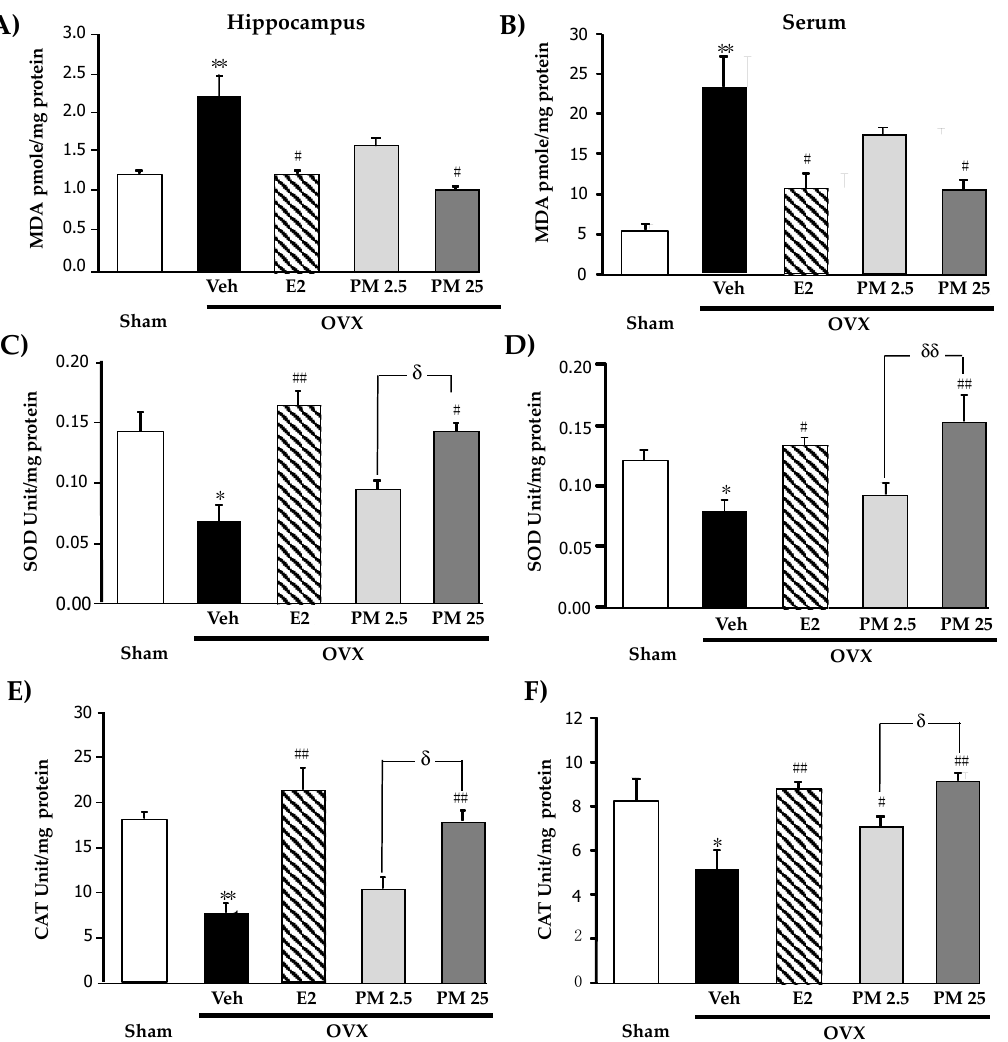
Figure 2. Effects of PM extract and estrogen on oxidative damage and antioxidant enzyme activities. ( A , B ) were the effects of PM extract and estrogen on oxidative damage in hippocampus and serum, respectively. ( C , D ) were the effects of PM extract and estrogen on SOD enzyme activity in hippocampus and serum, respectively. ( E , F ) were the effects of PM extract and estrogen on CAT enzyme activity in hippocampus and serum, respectively. The values given were the mean ± SEM (n = 5–6). * p < 0.05, ** p < 0.001 vs. sham-operated group, # p < 0.05, ## p < 0.001 vs. the OVX group, δ p < 0.05 and δδ p < 0.001 p < 0.05 vs. the PM extract (post-hoc Tukey test).